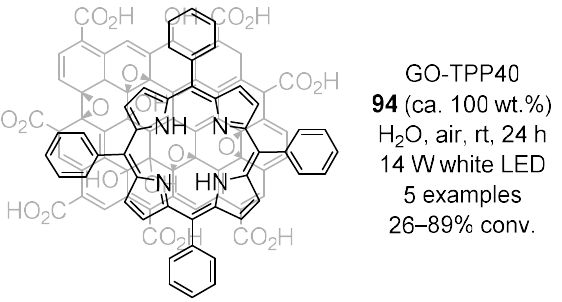
Figure 28. Results obtained in the aerobic photo-oxidation of alcohols to aldehydes 69 catalyzed by 94 .